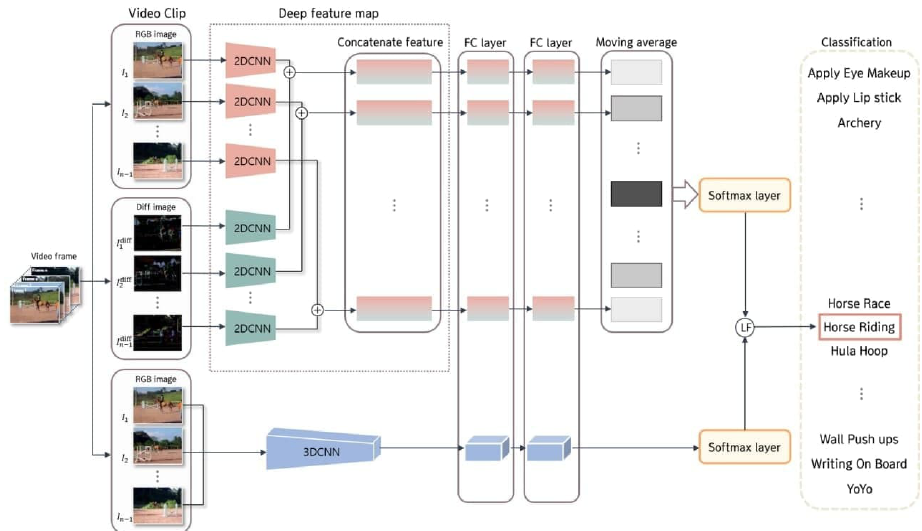
Figure 3. Architencture of the proposed action recognition